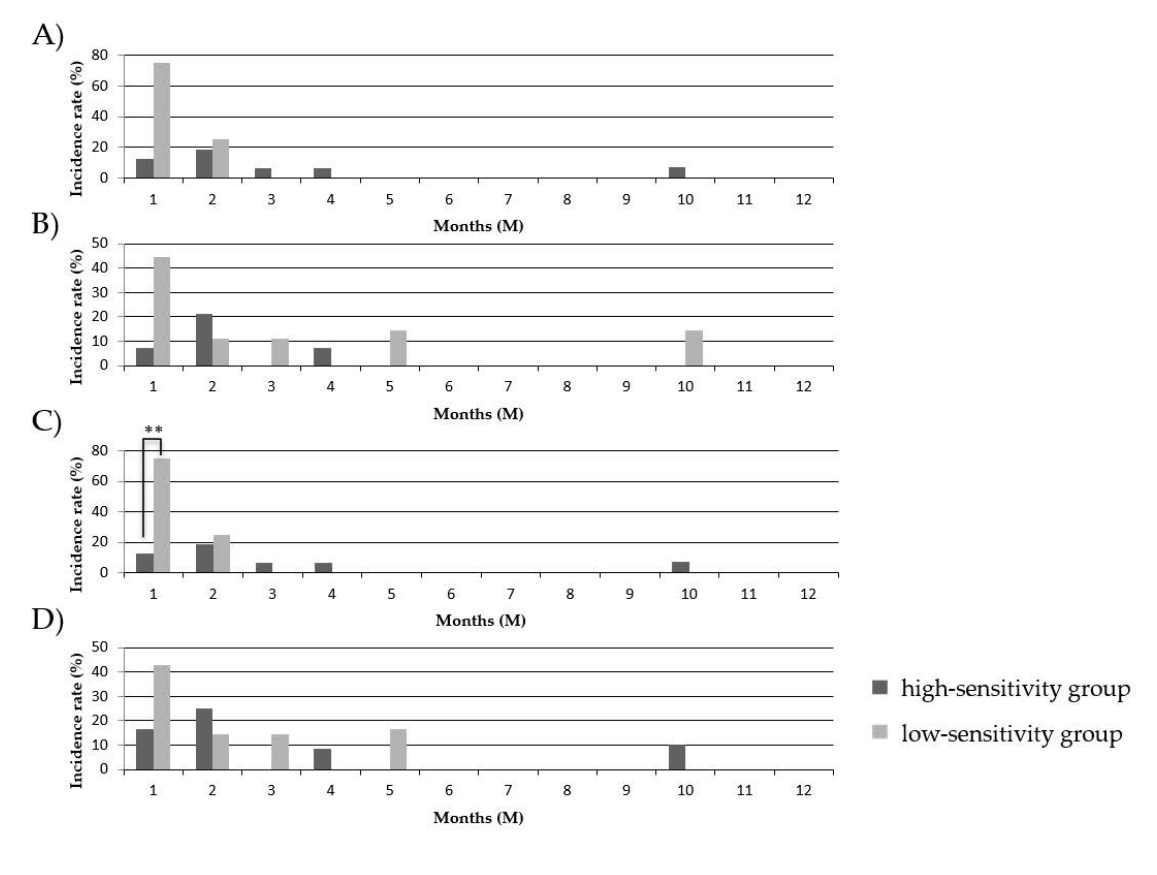
Figure 4. Comparison of the onset time of GC increase/resumption between the PBMC high-sensitivity group and the PBMC low-sensitivity group to GCs. The onset times of the increase/resumption of GC administrations in the PBMC high-sensitivity group and the PBMC low-sensitivity group to COR before transplantation ( A ), MPSL before transplantation ( B ), COR after transplantation ( C ), and MPSL after transplantation ( D ) were estimated. The statistical significance is presented as (**) for p <